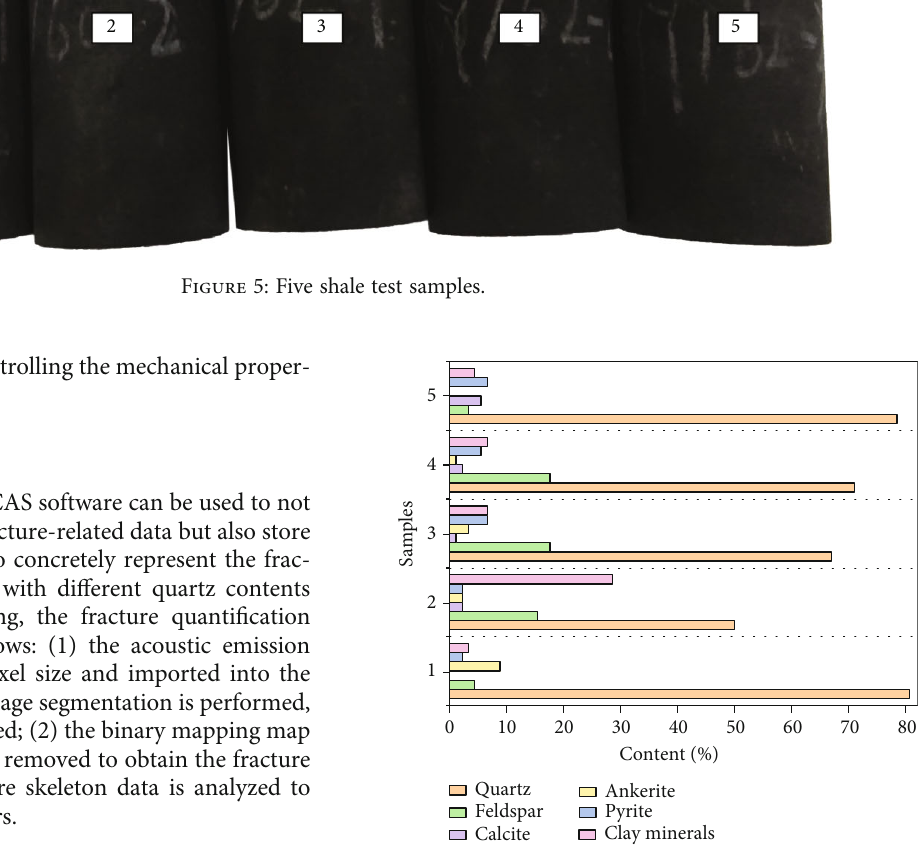
Figure 6: Mineral content ratio of fi ve shale test samples (from Wang et al.